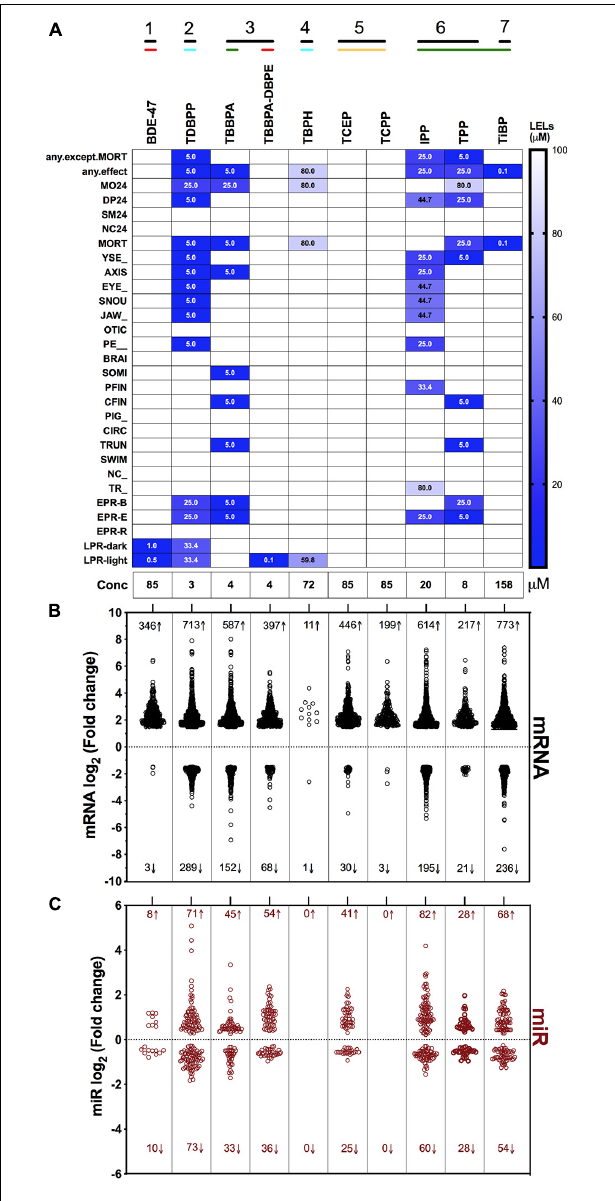
FIGURE 2 | Phenotypic screening, mRNA sequencing and miR sequencing of 10 FRCs. (A) Phenotypic screening with lowest effect level (LEL) of 18 morphological endpoints and four behavioral endpoints; details about these endpoints are included in Supplementary Table 1 . Data based on Truong et al. (2020). Exposure concentrations for this study are represented as “Conc.” Black lines with numbers indicate FRC classes based on Figure 1 . Colored lines indicate phenotypic response groups: – only behavior response; – morphology + behavior response; – only morphology response and – no response. Embryonic photomotor response is included within morphology response and behavior response indicates only larval photomotor response. Numbers within cells represent LELs for each FRC/endpoint combination. (B) Log 2 fold changes of all increased and decreased differentially expressed mRNAs across FRCs. Cutoff was log 2 fold change ≥ 1.5 and p ≤ 0.05. Numbers represent number of genes with increased ( ↑ ) or decreased ( ↓ ) mRNA levels. (C) Log 2 fold changes of increased and decreased miR levels across different FRCs. Cutoff was p ≤ 0.05. Numbers represent number of miRs with increased ( ↑ ) or decreased ( ↓ )